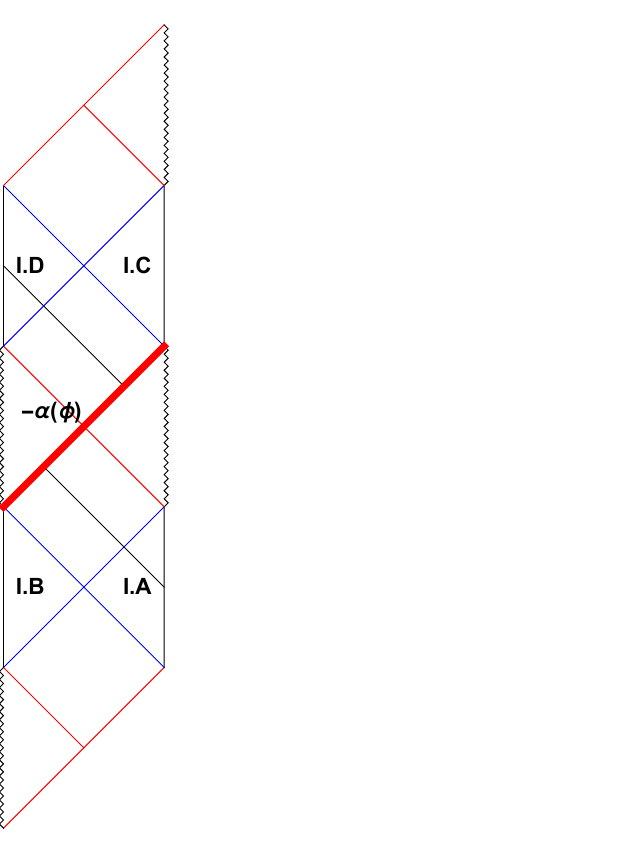
Figure 8 . The thick red line on u = 0 in the inner Kruskal region is a shockwave. The black line from region I.A is a null geodesic which encounters the shockwave at an angle (cid:30) , receives a kick of size (cid:11) ( (cid:30) ), and continues through to region I.D. If (cid:11) is negative, the kick is directed upward on the diagram due to the orientation of the Kruskal